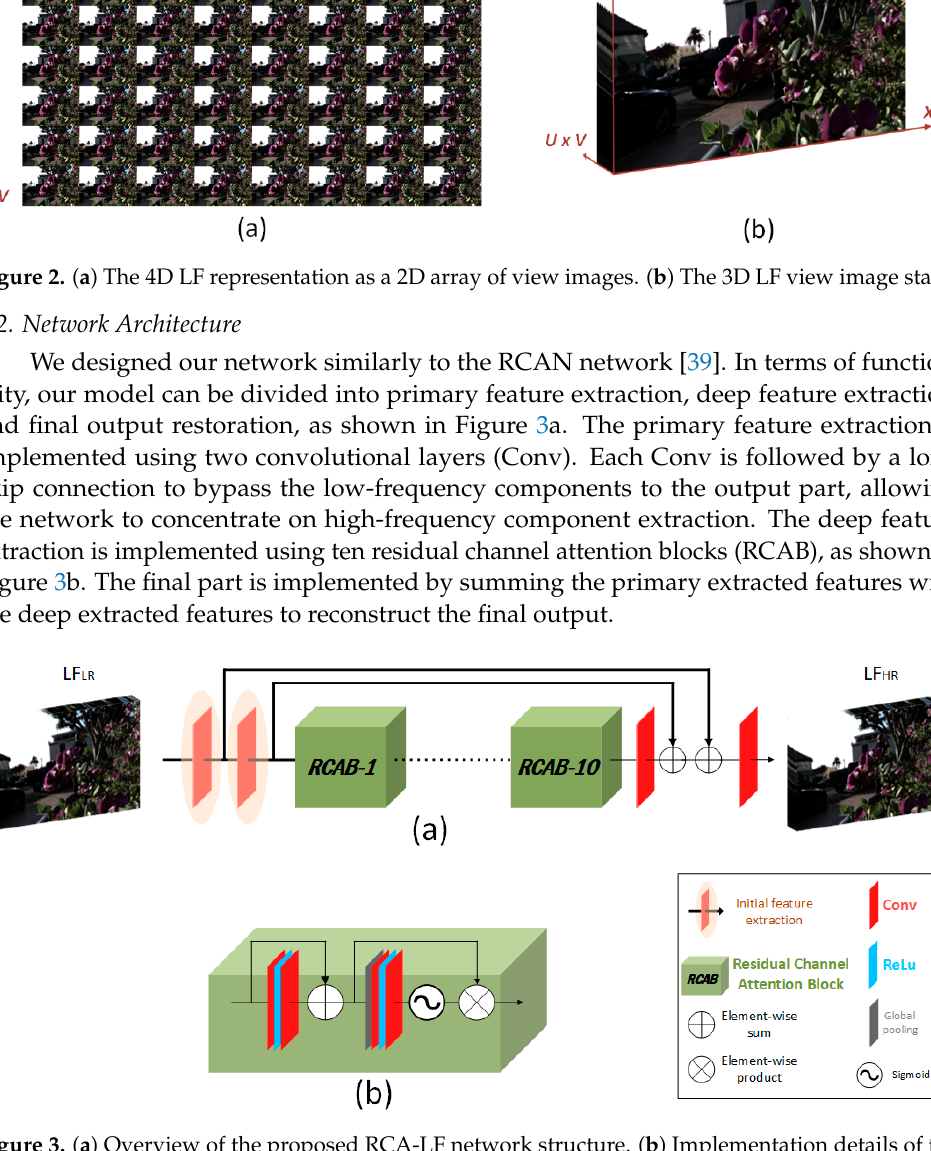
Figure 2. ( a ) The 4D LF representation as a 2D array of view images. ( b ) The 3D LF view image stack.